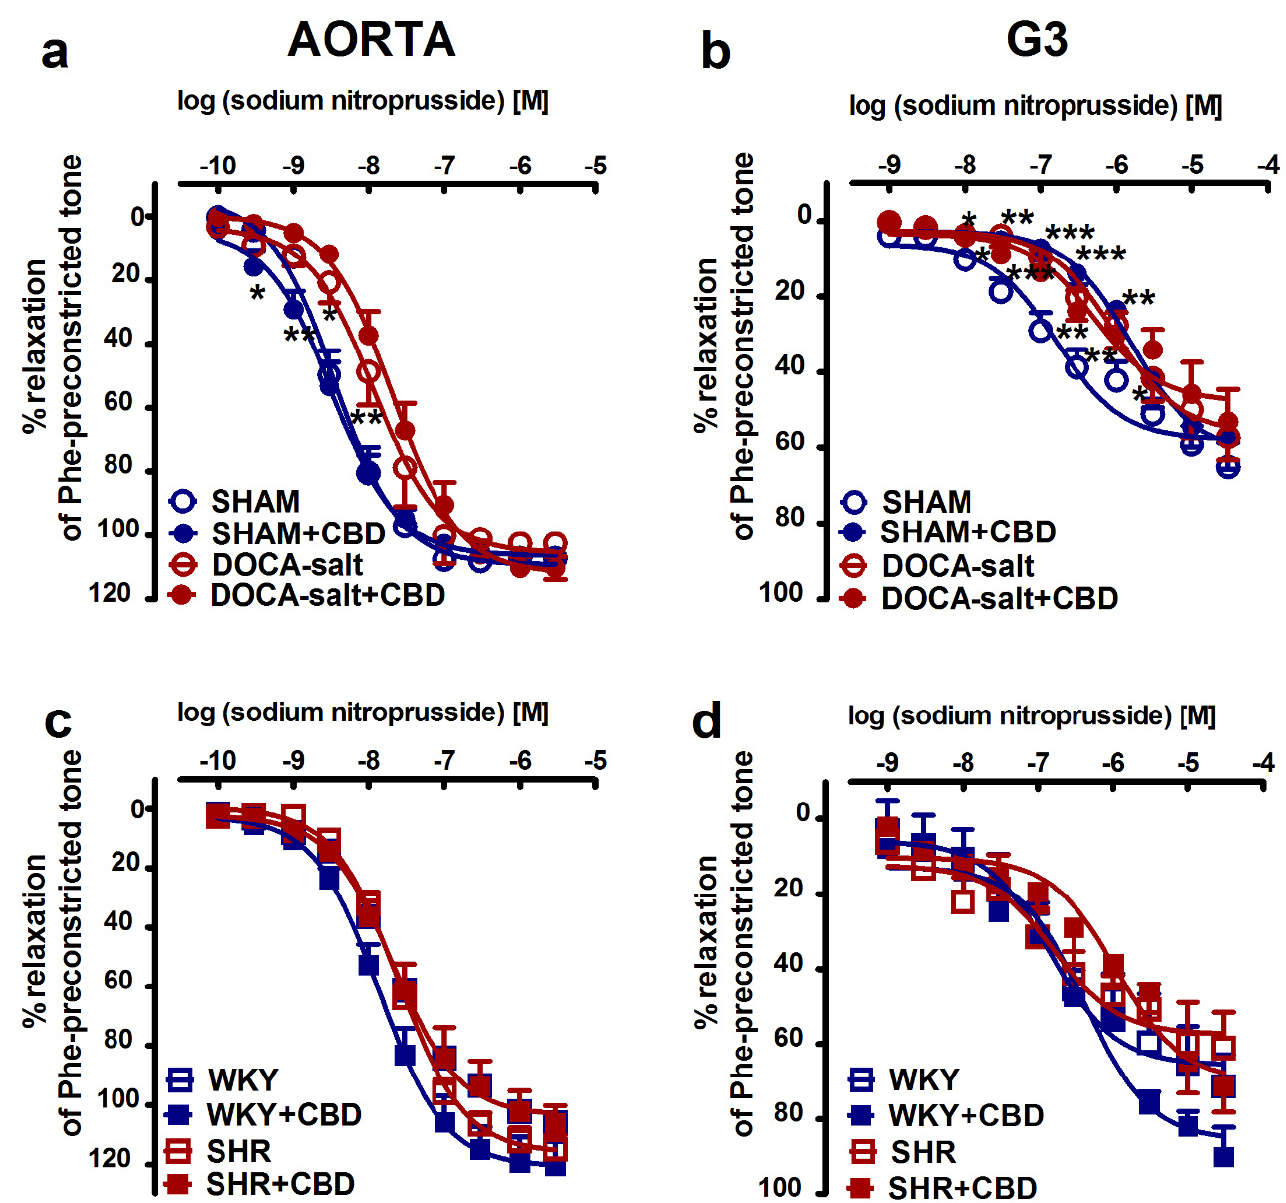
Figure 2. Influences of cannabidiol (CBD) and its vehicle on the vasorelaxant effects of sodium nitroprusside in aortas ( a , c ) and the mesenteric G3 arteries ( b , d ) isolated from deoxycorticosterone-induced (DOCA-salt) and spontaneously (SHR) hypertensive rats and their normotensive controls, sham-operated (SHAM) and Wistar–Kyoto (WKY) rats, respectively. CBD (10 mg/kg) or its vehicle was injected i.p. every 24 h for 14 days. Vasodilatory responses are shown as percentages of the reference response of the isometric contraction induced by phenylephrine (Phe). Mean ± SEM of n = 5–8 tissues for each curve. * p < 0.05, ** p < 0.01 and *** p < 0.001 compared to the respective control groups (* SHAM/WKY), as determined by one-way ANOVA followed by Bonferroni’s multiple-comparison tests. In a few cases, the SEM is smaller than or equal to the size of the symbol. See Tables 1 and 2 for statistical analysis.